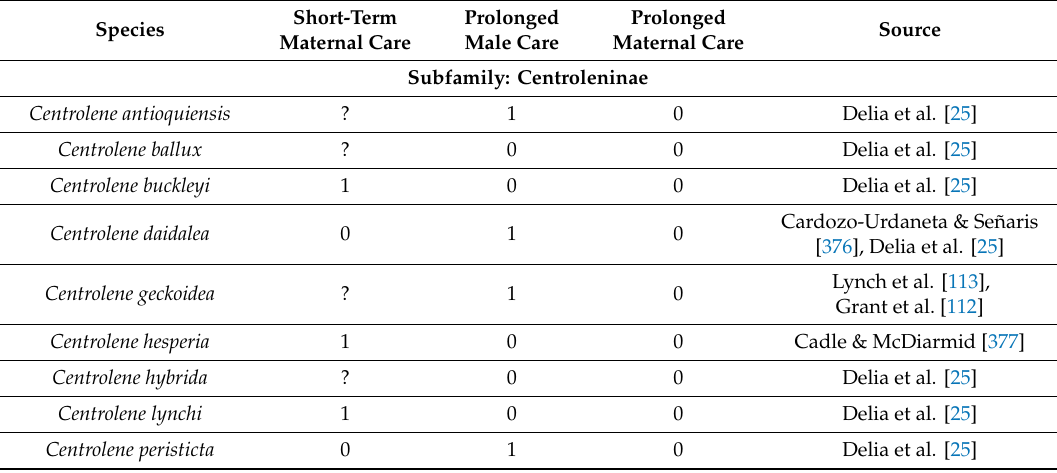
Table 8. Parental care in glassfrogs. Short-term maternal care = immediately after oviposition, female provides brooding to egg clutch for several hours; after this initial brooding, clutches remain unattended. Prolonged male care = male provides parental care to egg clutch for several days. Prolonged maternal care = female provides parental care to egg clutch for several days. Each type of parental care is coded as Absent (0), Present (1), or Unknown (?). Terminology and data are summarized from Delia et al.